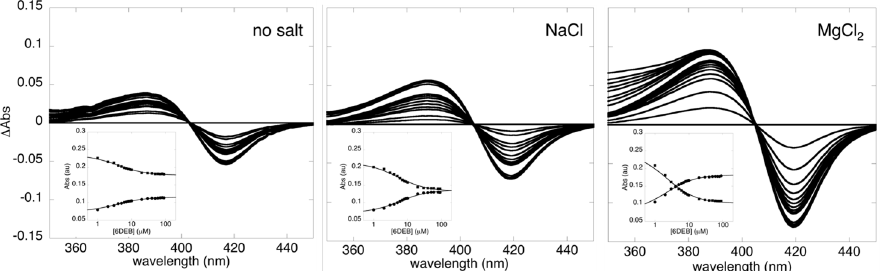
Figure 2. Divalent cations enhance the high-spin state shift induced by substrate binding to OleP. Equilibrium titrations of OleP with 6DEB in the absence (no salt) and in the presence of NaCl and MgCl 2 (I = 0.5 M). Different spectral changes observed upon substrate binding are shown. Insets report the absorbance intensities of OleP monitored at 419 nm (full squares) and at 388 nm (full dots) as a function of the logarithm of total 6DEB concentration. In the experiments, the protein has been used at a constant concentration in 50 mM Hepes, pH 7.5, at 298 K. Solid lines are the best fit to a hyperbolic